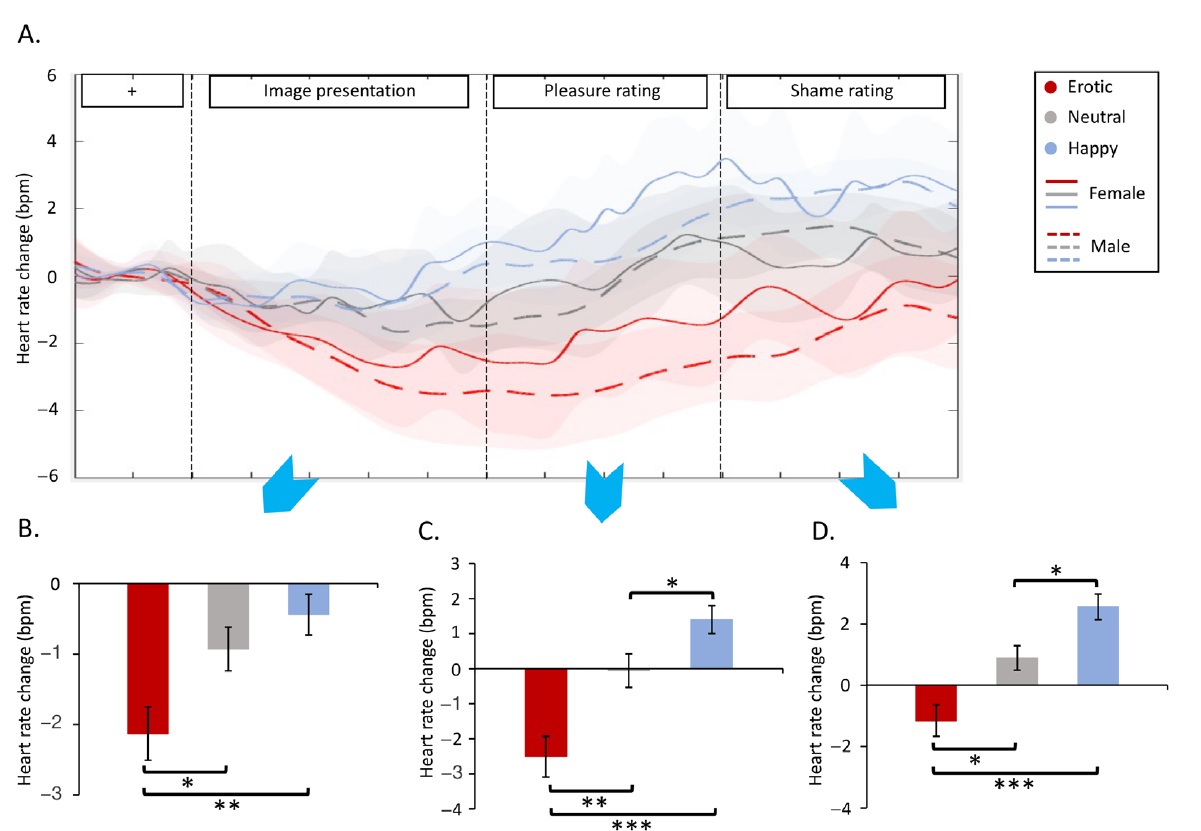
Figure 3. Heart rate results. ( A ) Heart rate dynamics across gender groups and stimuli ( B – D ) indicated heart rate statistics in the image presentation, pleasure rating, and shame rating phases, respectively. Dashed lines outline these phases; bpm denotes beat-per-minute; * p ≤ 0.05, ** p ≤ 0.01, *** p ≤ 0.001.